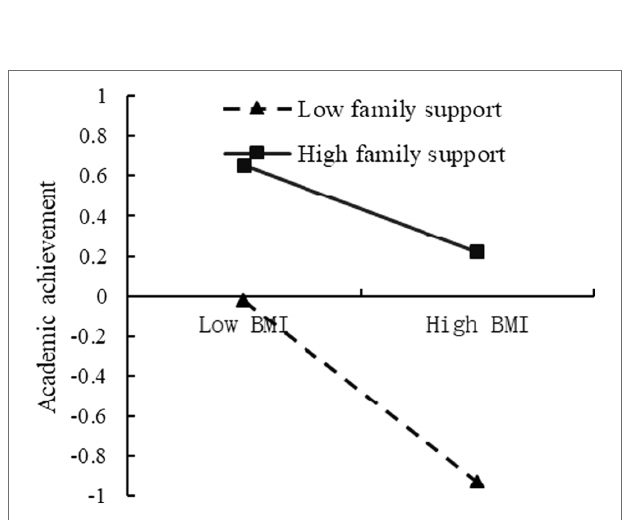
FIGURE 8 | The moderating effect of the family support on the relationship between BMI and academic achievement.